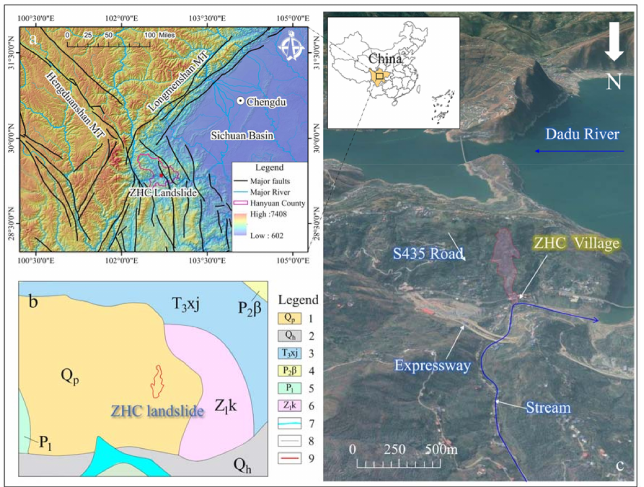
Figure 1. ( a ) Regional tectonic map. ( b ) Stratigraphic lithologic map: 1. Quaternary Pleistocene diluvium; 2. Quaternary Holocene diluvium; 3. Upper Triassic Xujiahe Formation which are composed of thinly layered purplish-red mudstone intercalated with light yellow sandstone; 4. Upper Permian Emeishan basalt; 5. Lower Permian limestone; 6. Dark purple feldspar-lithic sandstone of the lower Sinian Kaijianqiao Formation; 7. Dadu River; 8. Geological boundaries; 9. Boundary of ZHC landslide). ( c ) Geomorphology map of the ZHC